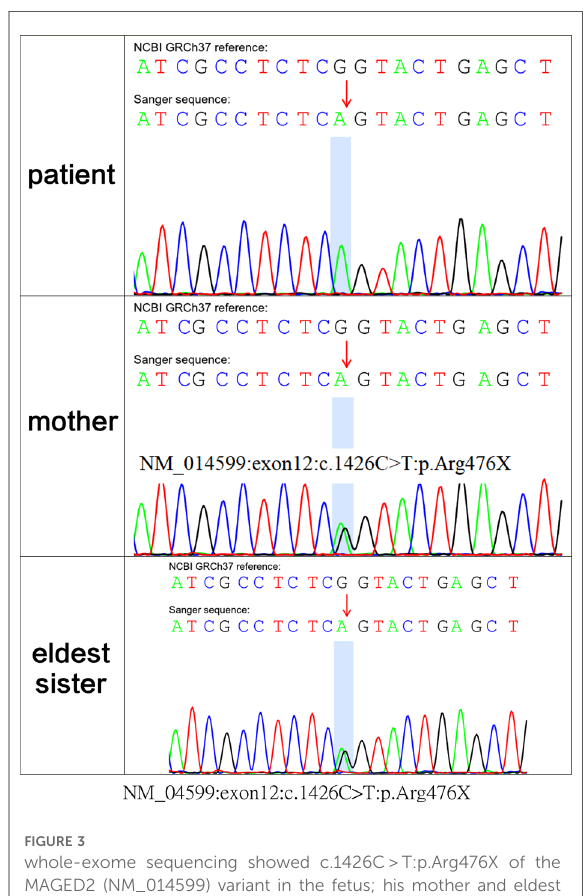
FIGURE 3 whole-exome sequencing showed c.1426C>T:p.Arg476X of the MAGED2 (NM_014599) variant in the fetus; his mother and eldest sister carried the variant in the heterozygous